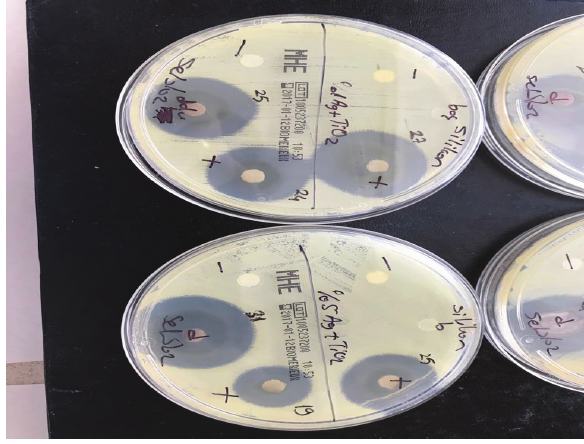
Figure 3: DTA and TG analysis of pure TiO nanofibers.